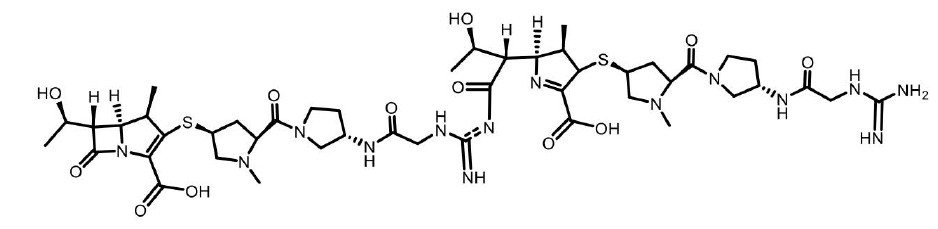
Figure 9. Stability of solid CS-023 at 40 °C under humidity at: ( a ) 0% RH, ( b ) 75% RH.